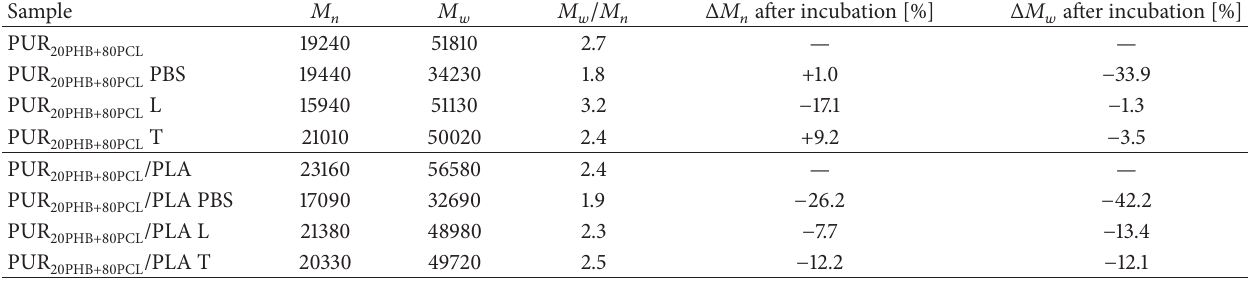
) and its blend (PUR /PLA) before and after incubation in PBS, lipase 20PHB+80PCL 20PHB+80PCL